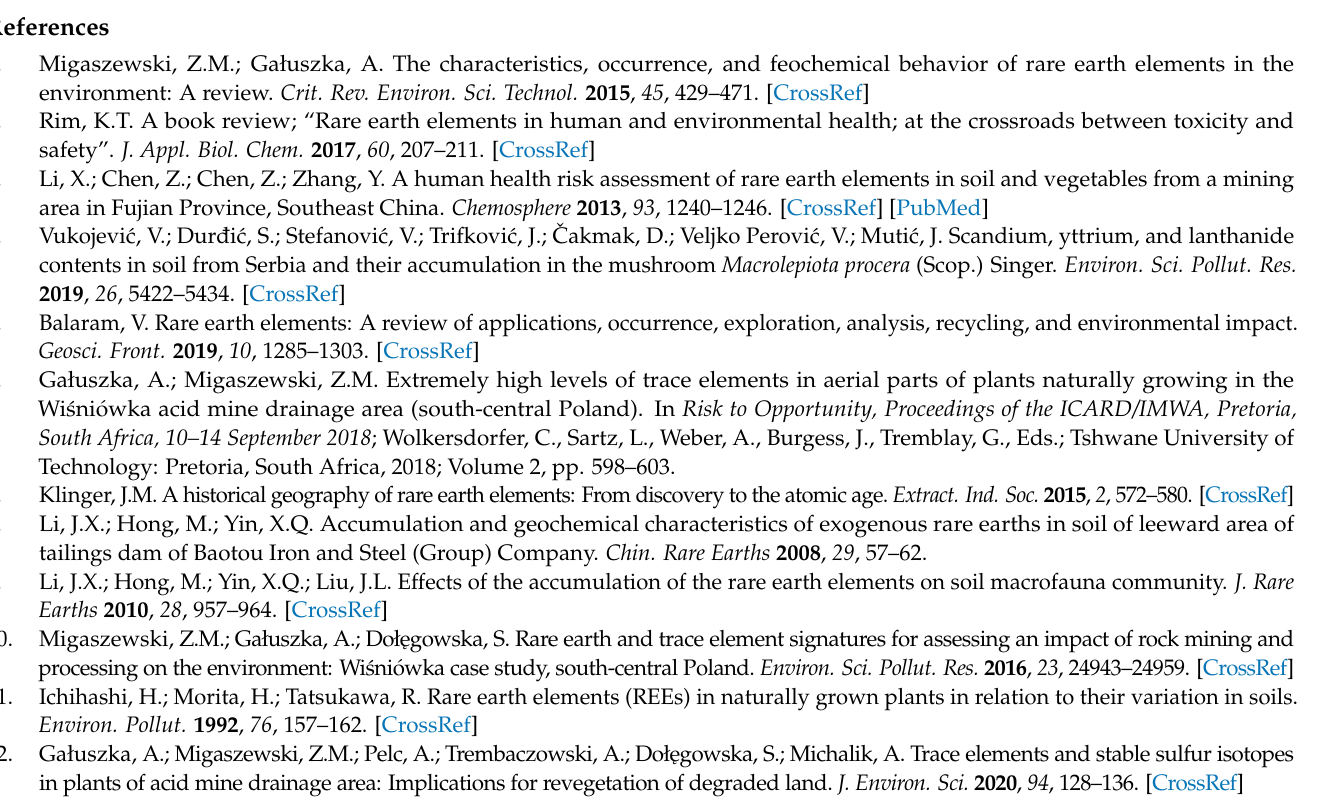
Figure S2: The shale (NASC, PAAS, EUS and WSH) normalised patterns of REE in B. edulis [medians for the caps (a), stipes (b) and the whole fruiting bodies (c)]. Figure S3. Shale (NASC, PAAS, EUS and WSH) log-normalised patterns of REY in B. edulis (whole fruiting bodies) from the sites (a) Mor ˛ag and (b) August ó w, and (c) Bau et al. (2018). Figure S4: Shale (NASC, PAAS, EUS and WSH) log-normalised patterns of REE in B. edulis (whole fruiting bodies) from the sites (a) Mor ˛ag and (b) August ó w, and (c) Bau et al.